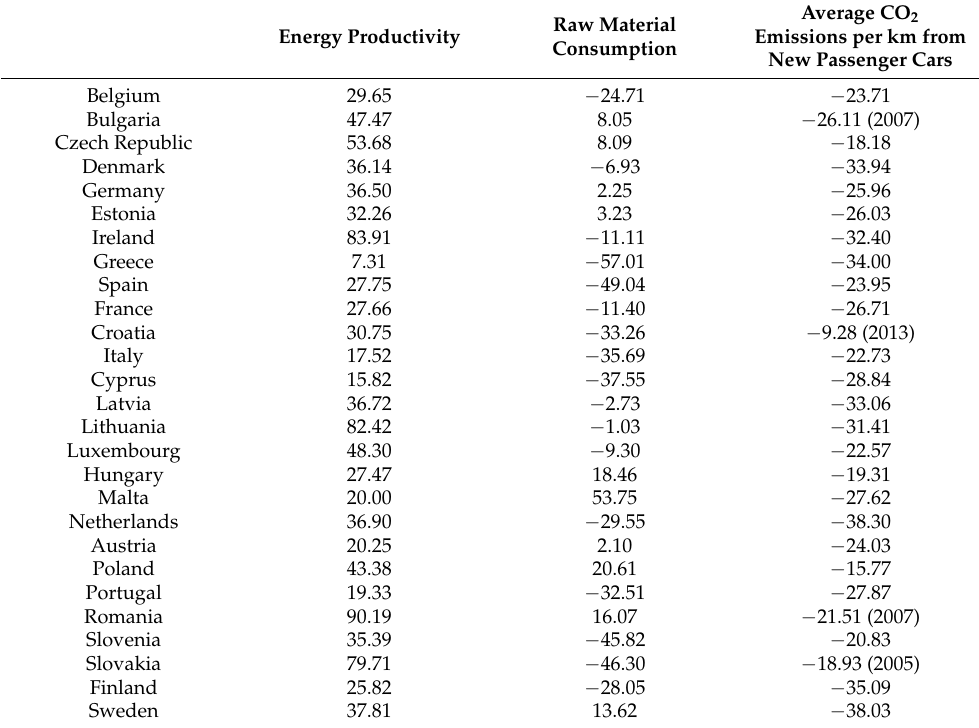
Table 3. Selected indicators of the 12th goal of the 2030 Agenda.